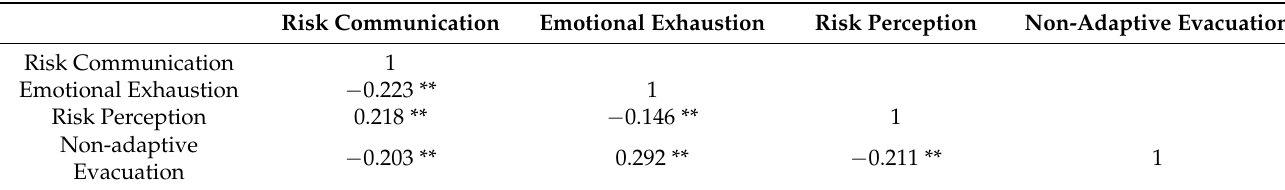
Table 3. Correlation analysis of variables.